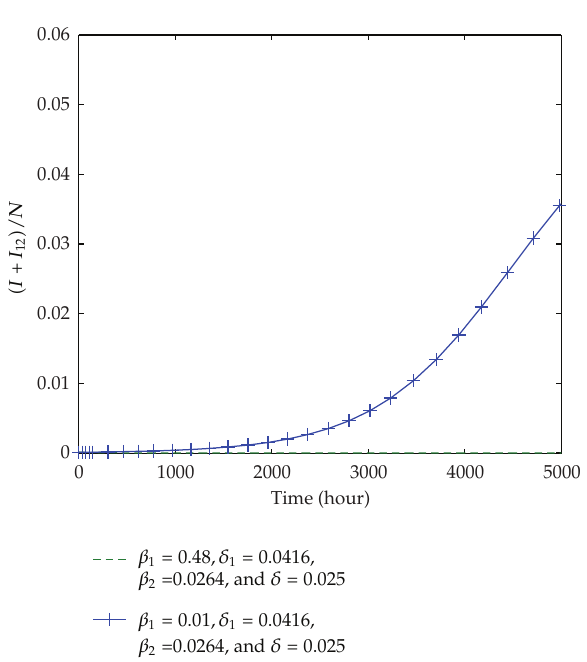
Figure 1: Fraction of computers infected with noncooperative worm: (cid:3) i (cid:4) green: the cooperative worm exists < 1 and (cid:3) ii (cid:4) blue: the cooperative worm dies out and R 2 and R 12 0